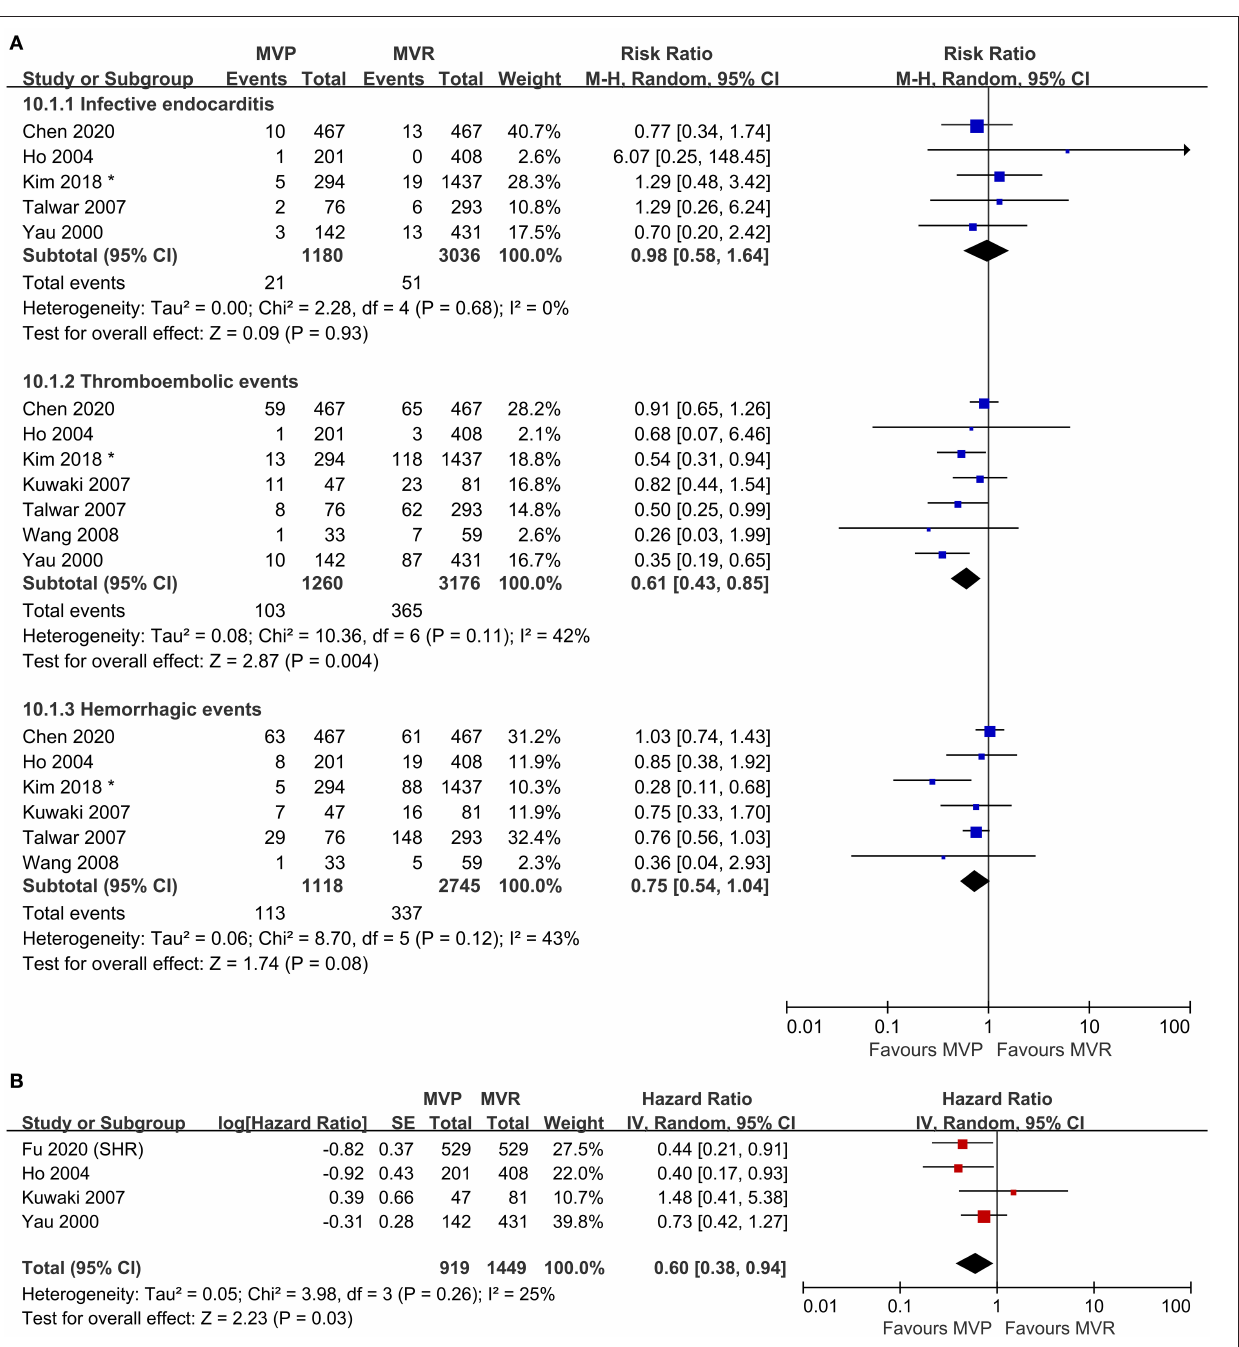
FIGURE 3 | Forest plots showing the results for valve-related adverse events. (A) Adverse events, including infective endocarditis, thromboembolic events, and hemorrhagic events and (B) freedom from valve-related adverse events. MVP, mitral valve repair; MVR, mitral valve replacement; M-H, Mantel-Haenszel; CI, confidence interval; SE, standard error; IV, Inverse-Variance; SHR, subdistribution hazard ratio; *before matching.